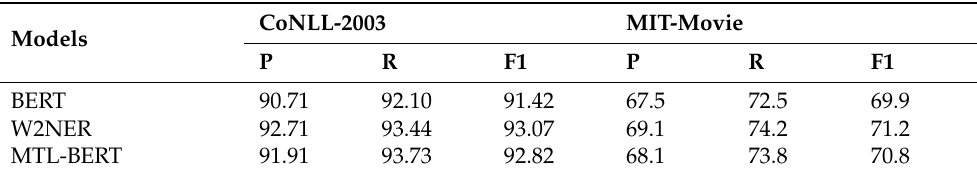
Table 6. Comparison of the performance of the BERT and MTL-BERT models regarding the separate F1 values of the two subtasks